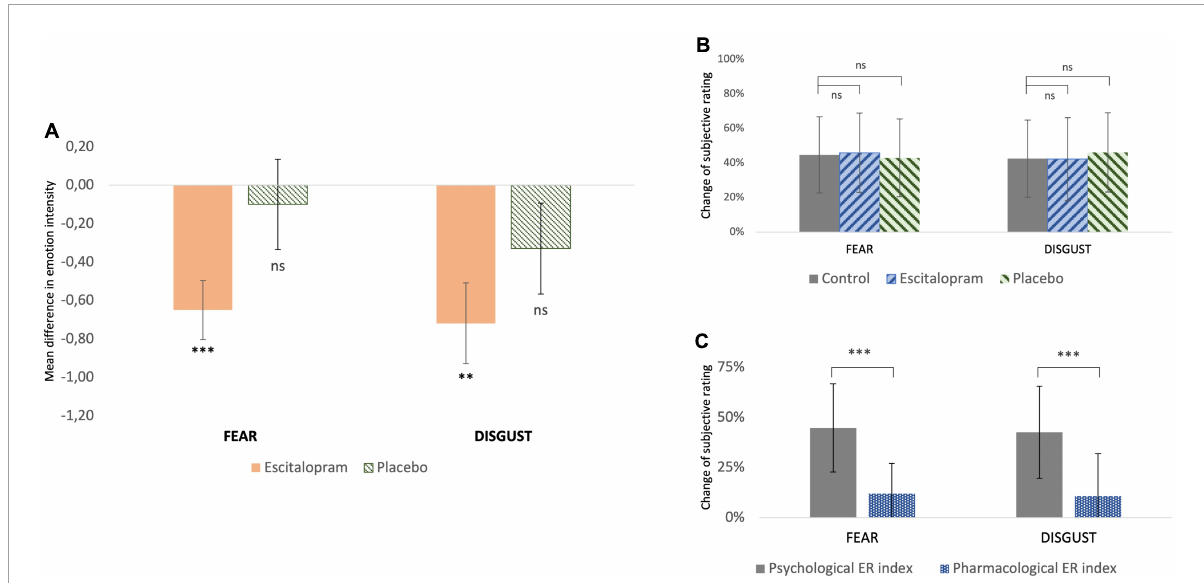
FIGURE2 Behavioral measures (A) change of subjective rating of emotion intensity from baseline (control) after pharmacological intervention with escitalopram and placebo, respectively. For both fear and disgust, escitalopram significantly reduced emotion induction, whereas placebo had no significant effect (shown mean difference and SE in score in a scale 1-9, significance asterisk declare significance related to 0). (B) Change of subjective rating of emotion intensity while applying reappraisal before (control) and after pharmacological intervention with escitalopram and placebo, respectively. (C) Effortful emotion regulation with reappraisal (operationalized as psychological ER index) was associated with a mean decrease of ca 45% in emotion induction of both fear and disgust. This reduction was significantly larger than the one associated with one dose escitalopram (operationalized as pharmacological ER index) under the conditions of this